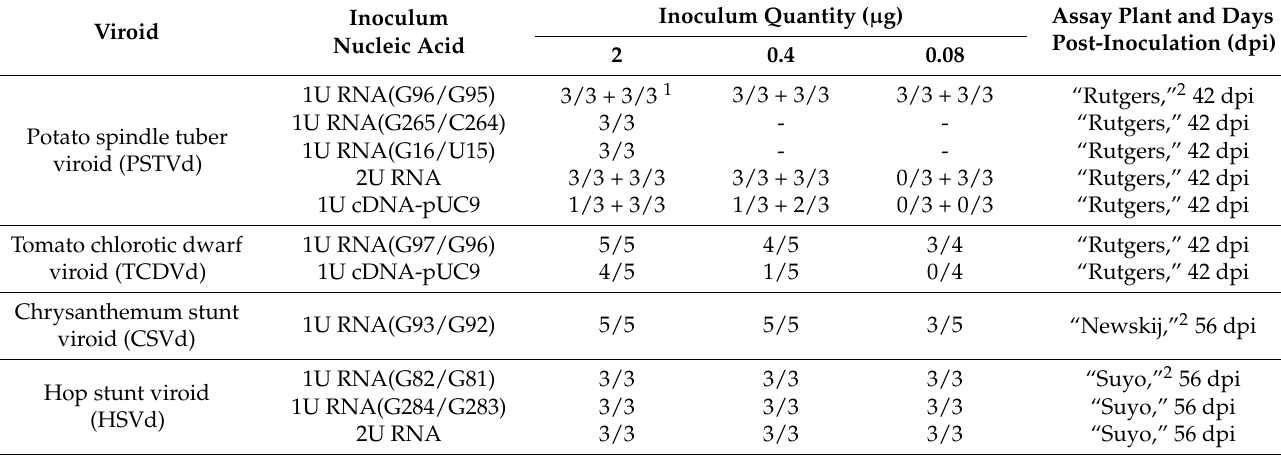
Table 1. Infectivity of monomeric or dimeric viroid RNA transcripts and plasmid DNA containing monomeric viroid cDNA.